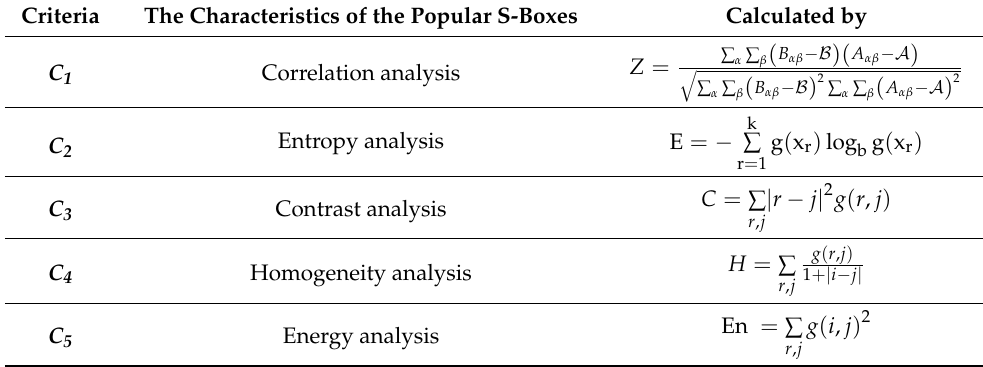
Table 3. The characteristics of the popular S-boxes. Criteria The Characteristics of the Popular S-Boxes